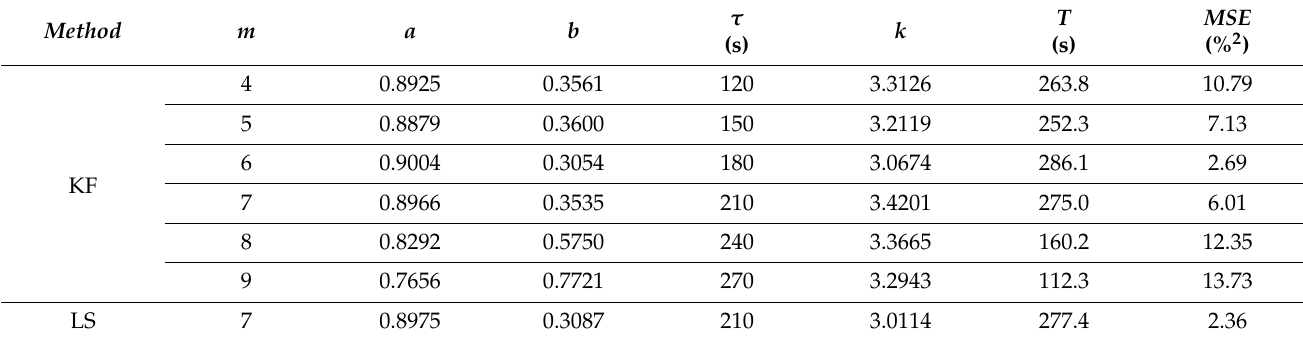
Table 1. Examples of the waveforms of the step response of the identified dynamic models and the waveforms of the determined parameters of Equation (2) are shown in Figures 6 and 7. Table 1. Results of the identification of the dynamic properties of the hard coal flotation